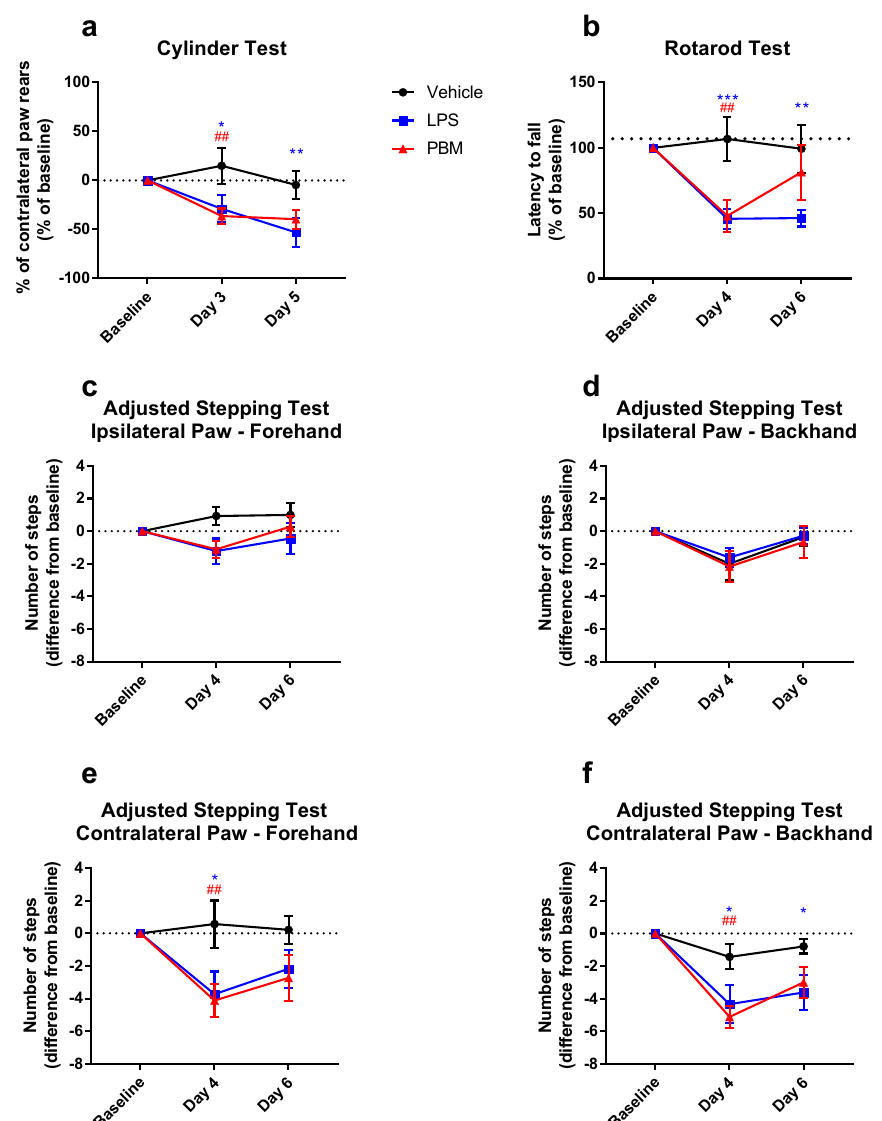
Figure 5. Motor behaviour in the cylinder, rotarod, and adjusted stepping tests before and after 20 µ g LPS injection and PBM treatment. ( a ) Proportion of rears led with the paw contralateral to injection in the cylinder test. There was a significant di ff erence compared to vehicle for both LPS (* p < 0.05) and PBM ( ## p < 0.01) groups at post-surgery day 3, which persisted for the LPS group at post-surgery day 5 (** p < 0.01). Vehicle: n = 7; LPS: n = 9; PBM: n = 8. ( b ) Time taken to fall o ff the rotarod. There was a significant di ff erence between LPS and vehicle groups at both time points (*** p < 0.001 at day 4; ** p < 0.01 at day 6) and between PBM and vehicle at post-surgery day 4 only ( ## p < 0.01). PBM rats improved on post-surgery day 6 but were not significantly different from LPS rats. Vehicle: n = 7; LPS: n = 9; PBM: n = 9. ( c ) There was no significant difference between groups in the number of adjusted steps made by rats with the ipsilateral (left) paw in the forehand direction in the adjusted stepping test, nor for the ( d ) ipsilateral paw backhand direction. ( e ) In the contralateral (right) paw, forehand direction, there was a significant di ff erence at post-surgery day 4 between LPS and vehicle groups (* p < 0.05) and between PBM and vehicle groups ( ## p < 0.01), but not between LPS and PBM groups. There were no significant di ff erences at post-surgery day 6. ( f ) In the contralateral paw backhand direction, there were significant di ff erences in the number of steps between LPS and vehicle groups at post-surgery days 4 and 6 (* emphp < 0.05) and between PBM and vehicle groups at post-surgery day 4 only ( ## p < 0.01). (c–f): Vehicle: n = 7; LPS: n = 9; PBM: n = 9. (a–f): Repeated-measures two-way ANOVA with Tukey multiple comparisons test. Values represent baseline-corrected means ±